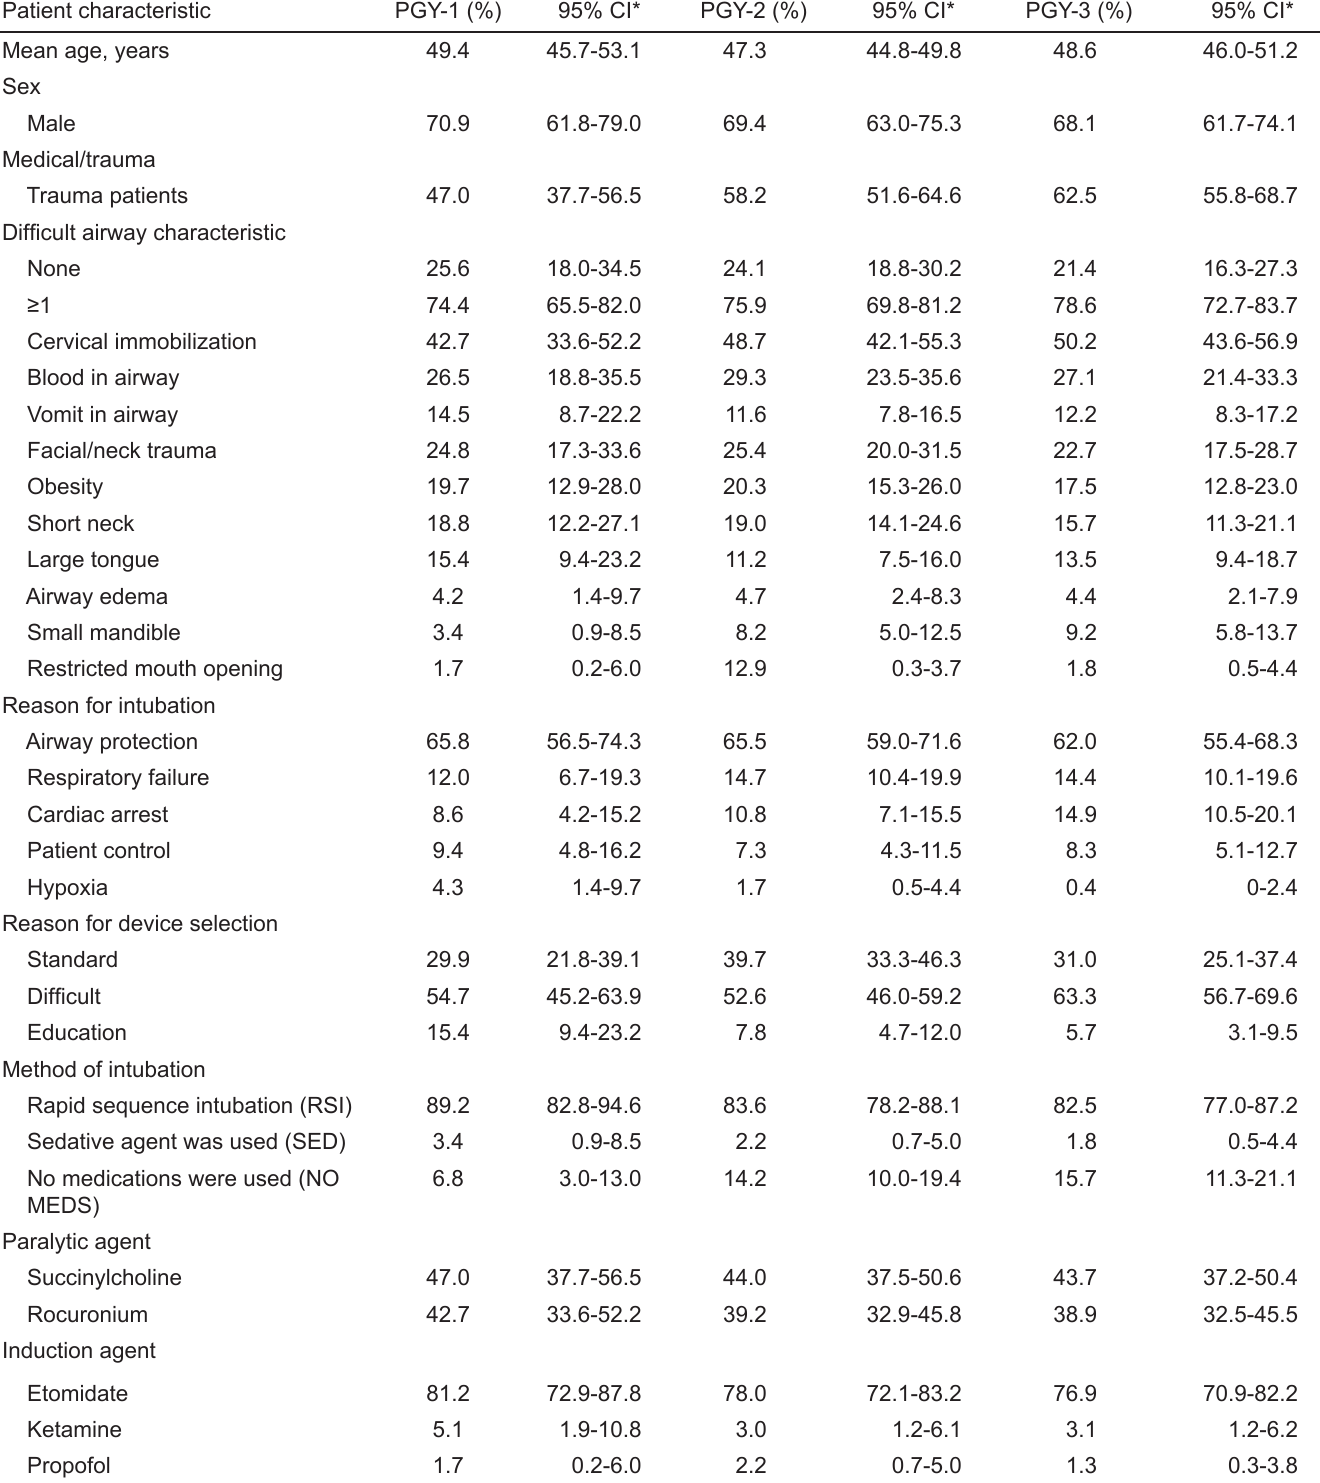
Table 1b. Patient and intubation characteristics by PGY in GVL